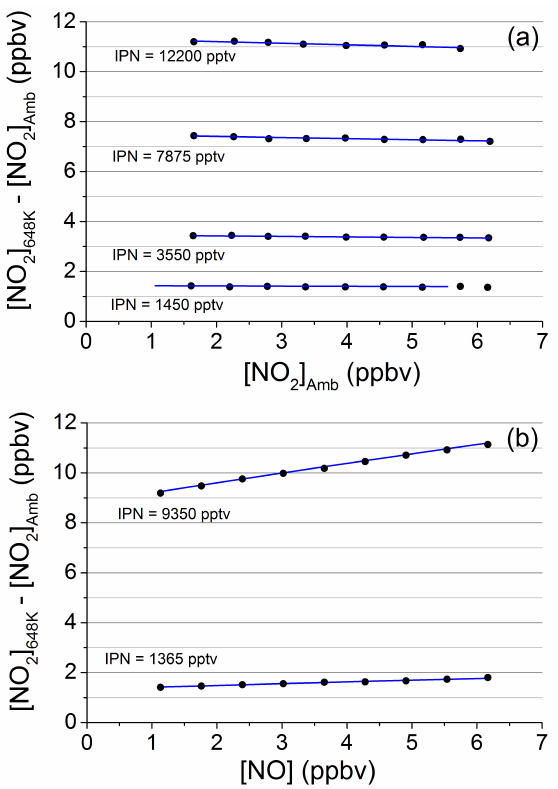
Figure 7. Modelled (lines) and measured difference between the NO 2 signal in the 648K channels and ambient temperature channel for i-propyl nitrate (IPN) samples and different added amounts of NO 2 (a) or NO (b) .